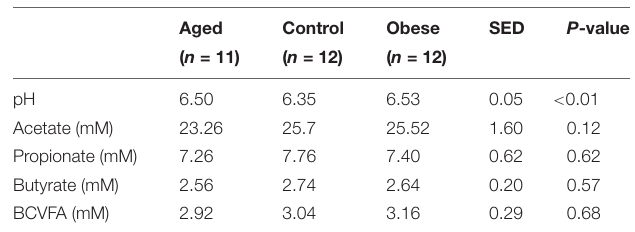
TABLE 6 | Mean pH and volatile fatty acid concentration in feces from obese, aged and control horses fed a diet of hay.